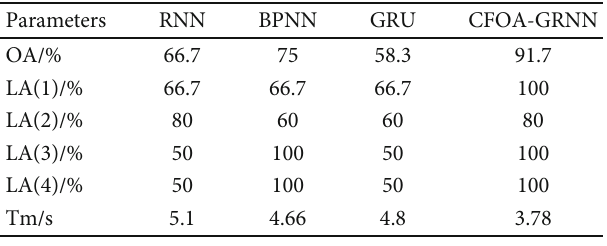
Table 3: Comparison of the evaluation results of each